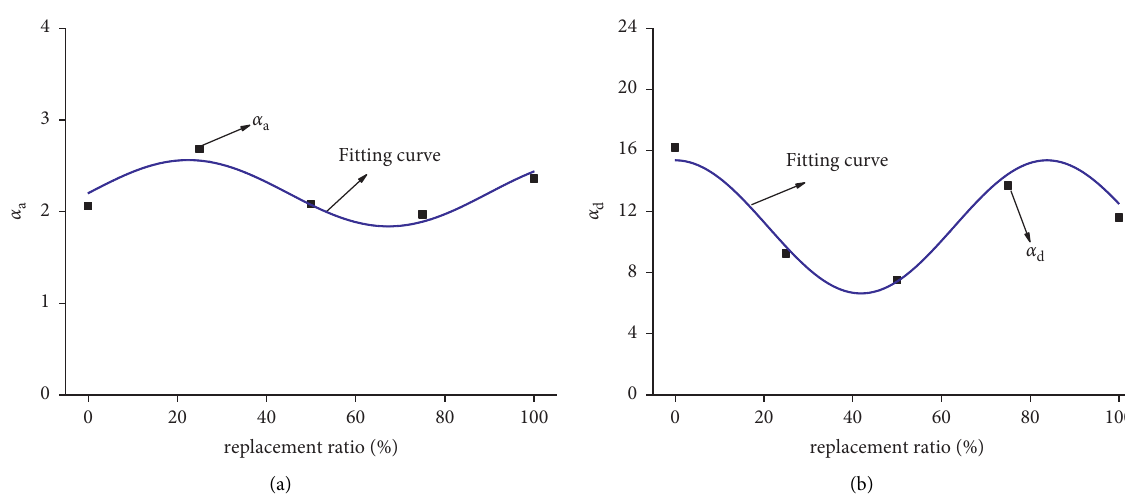
a and replacement ratio. (b) Fitting curve of α d and replacement ratio.